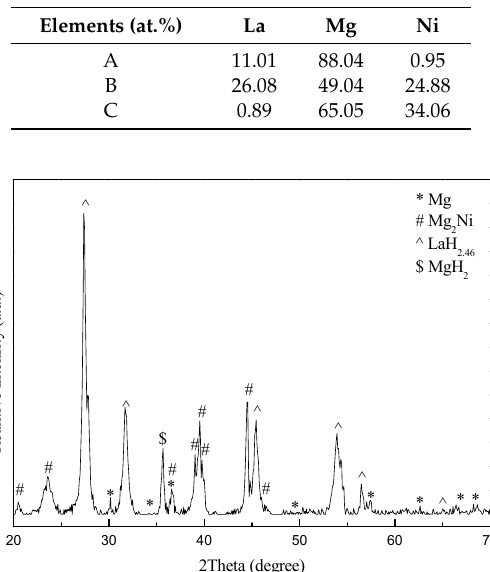
Figure 4. The P–C–T curves of the La 7.0 Mg 75.5 Ni 17.5 alloy at different temperatures.